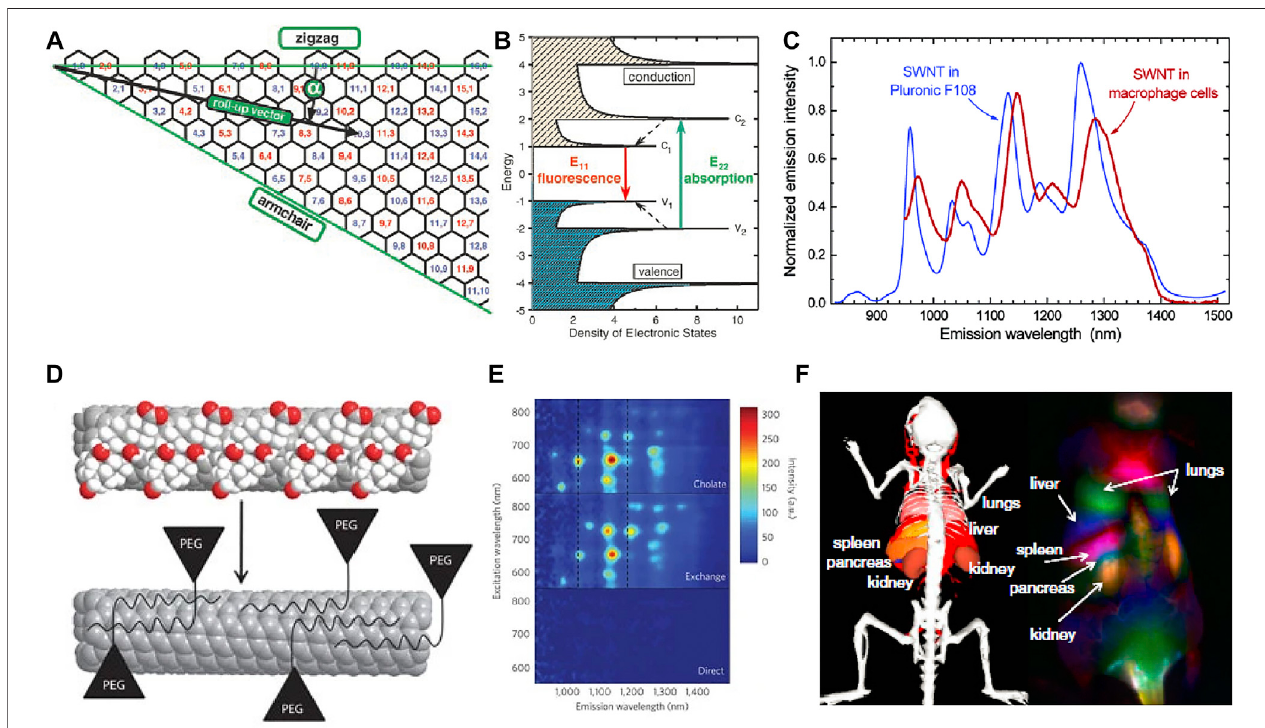
FIGURE 1 | (A) Schematic of the graphene sheet segment showing roll-up vector. (B) Schematic density of electronic states for SWCNTs with van Hove singularities(Bachiloetal.,2002)ReproducedwithpermissionfromWeismanetal.(2002). (C) SWCNTemissionspectrainanaqueousPluronicF108suspensionandin macrophage cells (Cherukuri et al., 2004). Reproduced with permission from Weisman et al. (2004). (D) Schematic of the phospholipid-polyethylene glycol modi fi ed biocompatible nanotubes. (E) Photoluminescence versus excitation spectra (Diao et al., 2012). Reproduced with permission from Dai et al. (2012). (F) Dynamic contrast-enhanced imaging with SWNCTs through PCA (Welsher et al., 2011). Reproduced with permission from Dai et al.